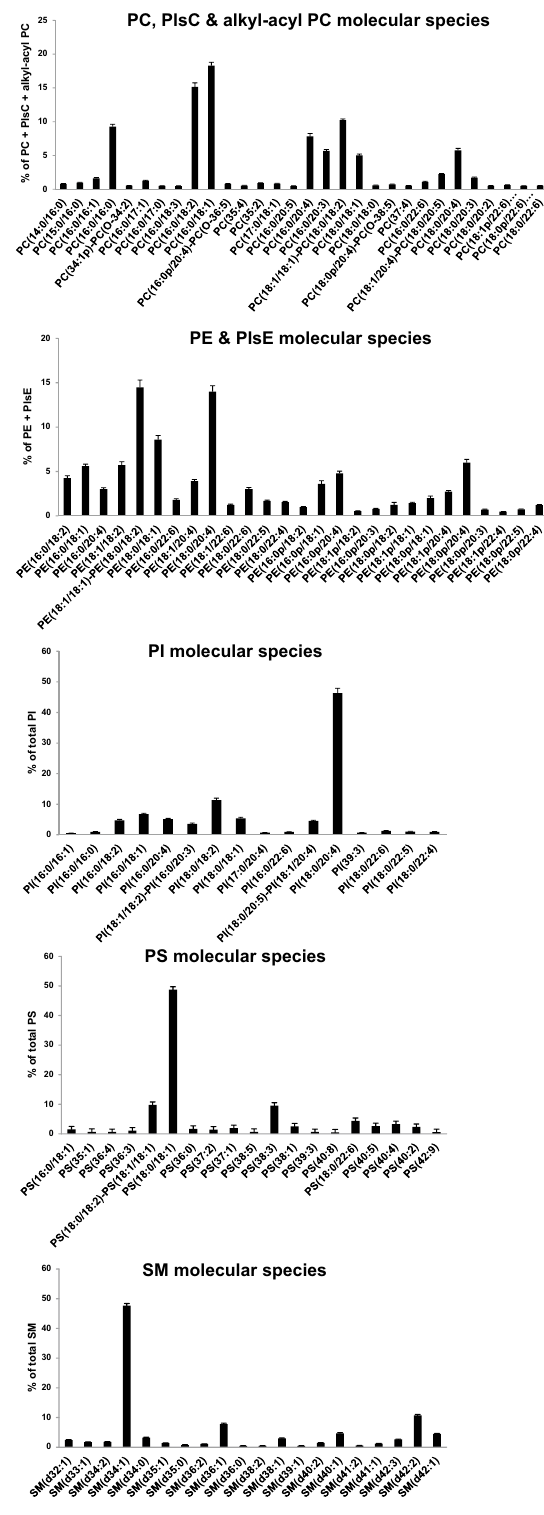
Figure 3. Concentrations of individual phospholipid species identified in human nasal mucosa. Values are presented as the mean ± sem (n = 23). Only species with levels > 0.5% are shown. Complete data are provided in Supplementary Table